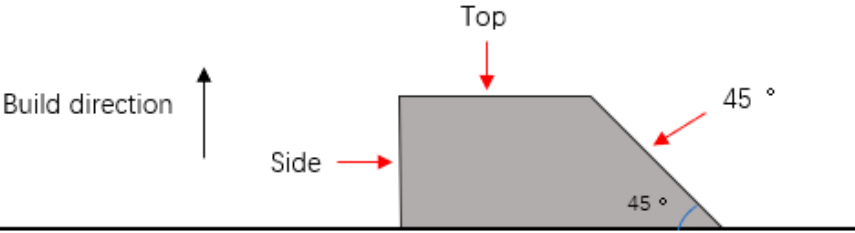
Figure 1. The printing method of the sample and the schematic diagram of the top surface, 45 ◦ surface and side